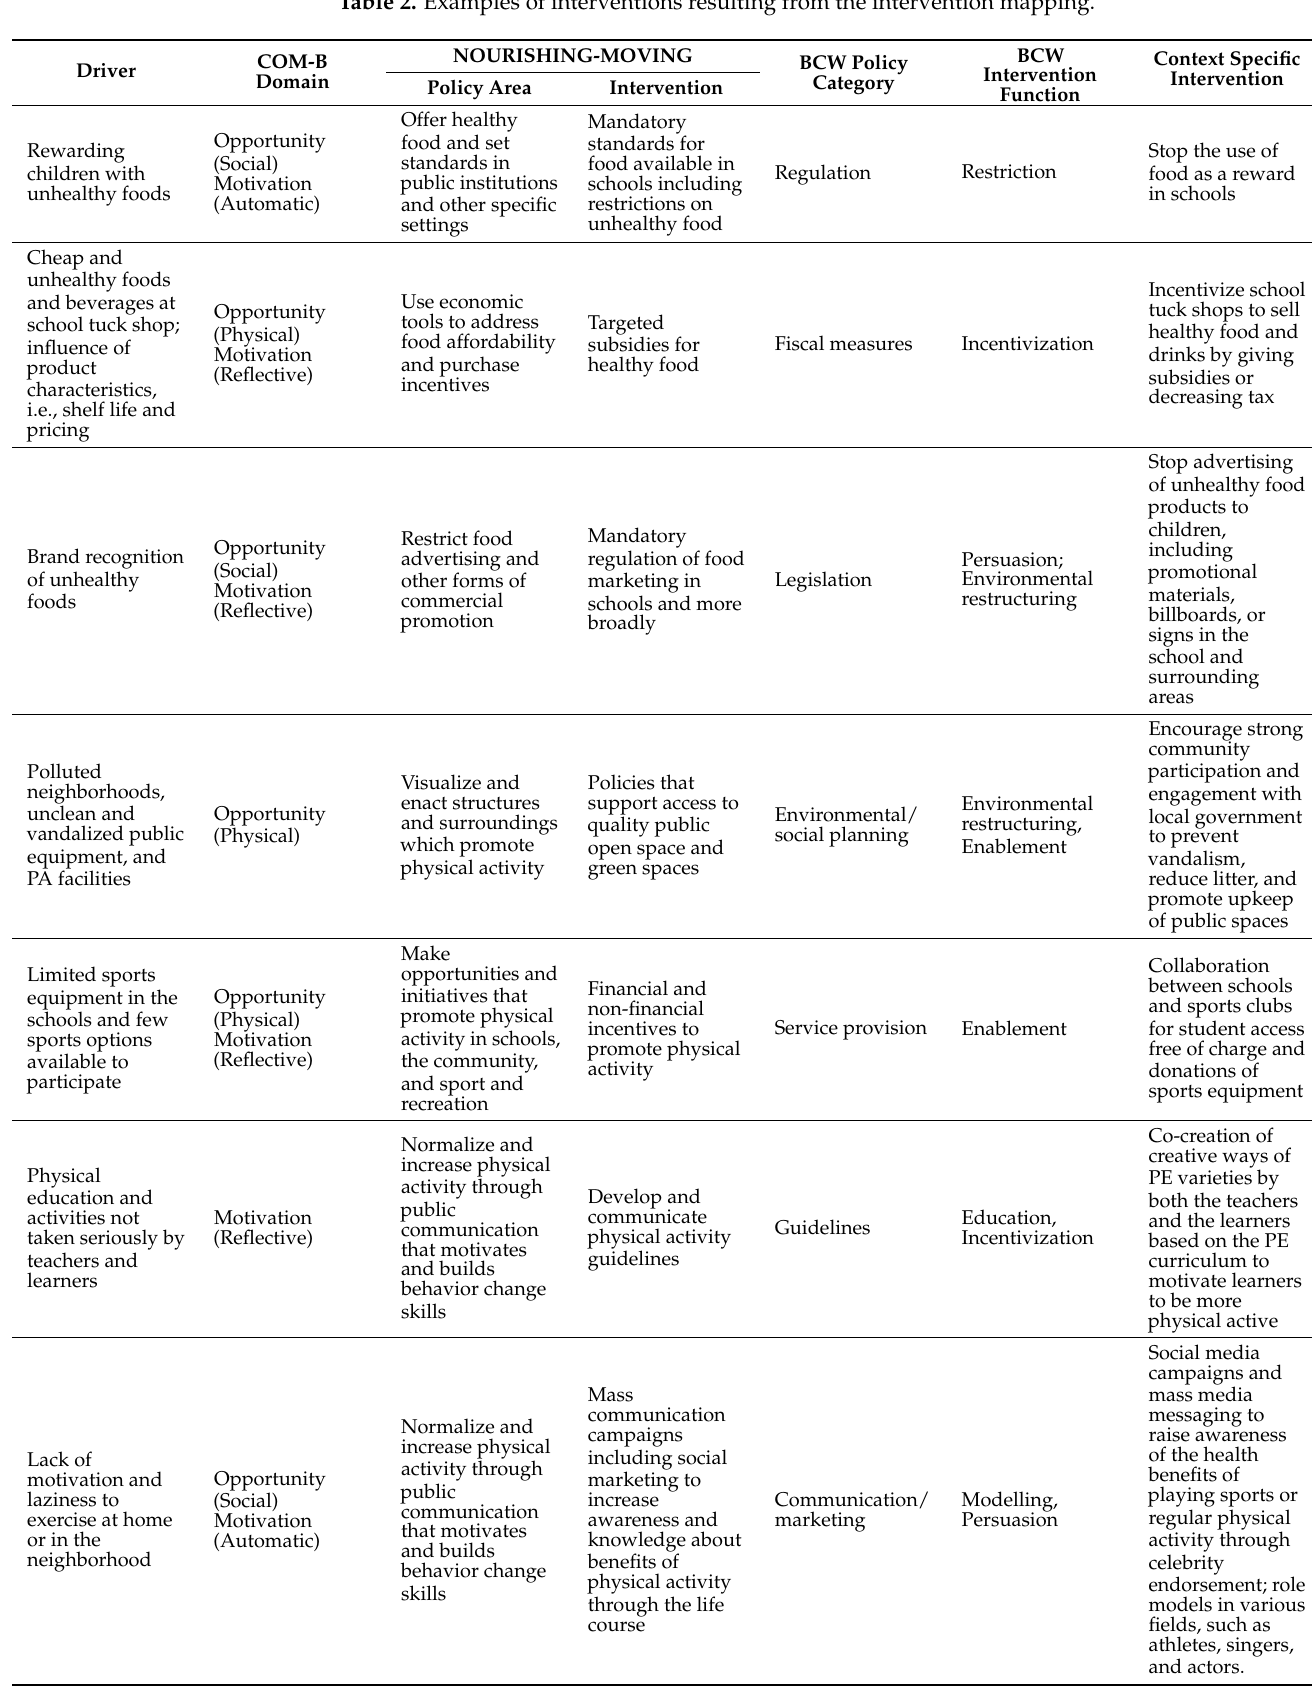
Table 2. Examples of interventions resulting from the intervention